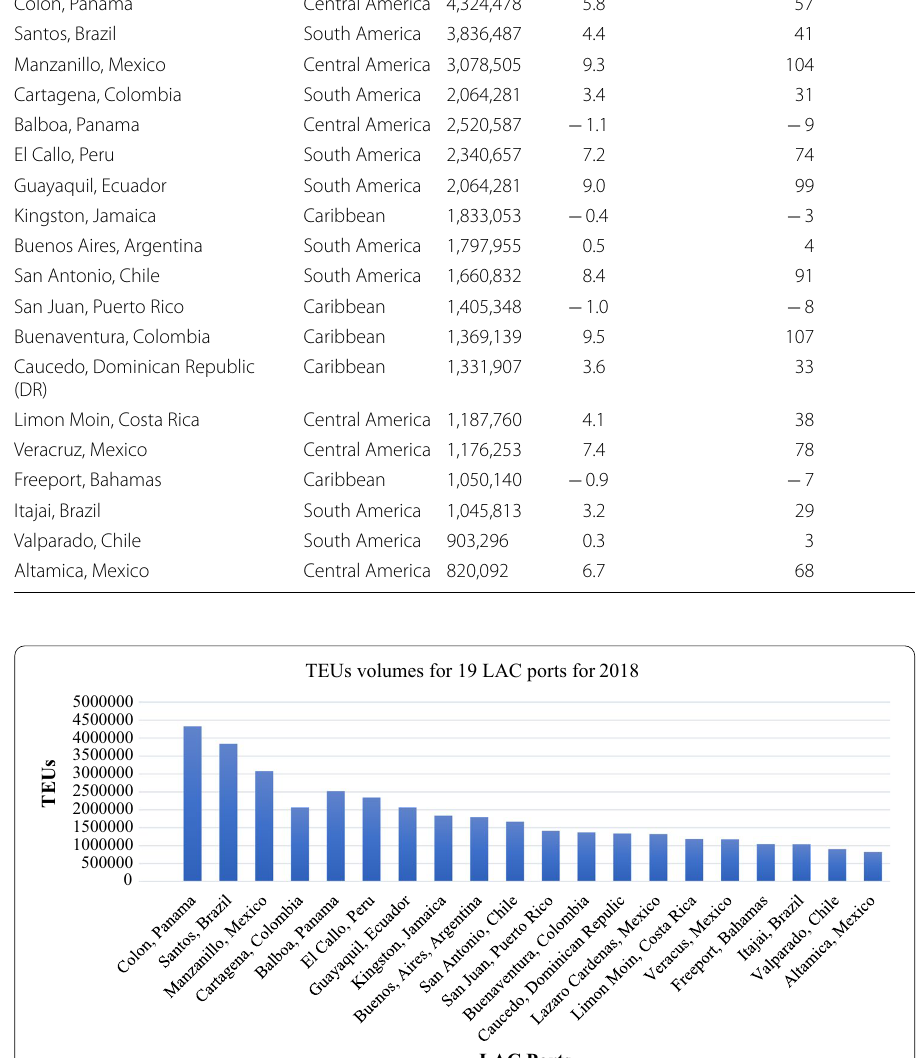
Compound annual Growth rate (TEUs) 2018 growth rate, 2010– 2010–2018 (%)